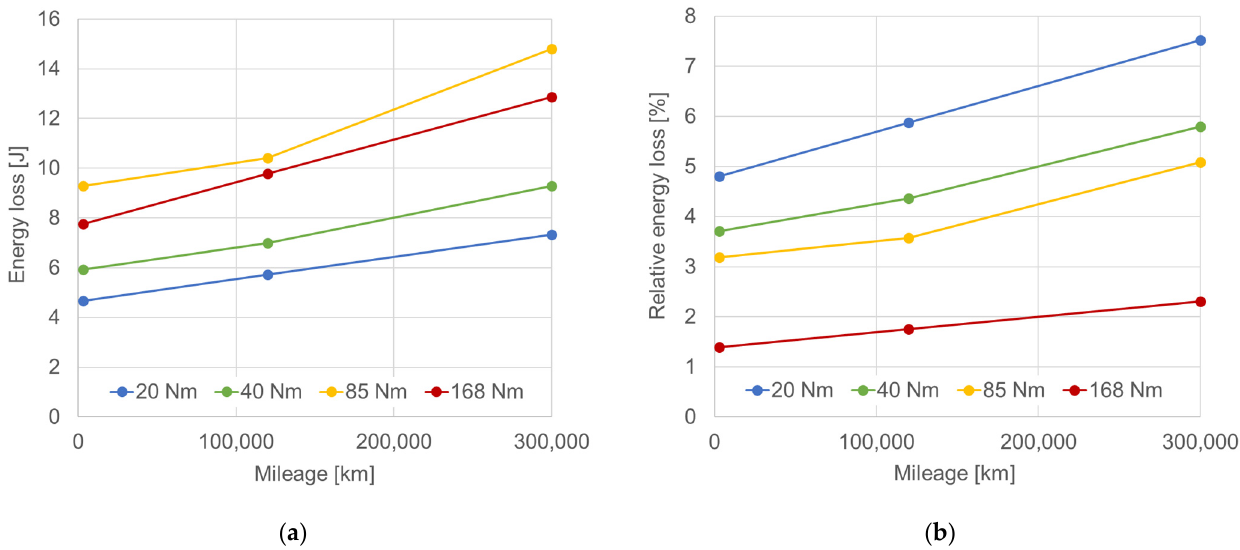
Figure 12. The energy lost by cycle due to blow-by at different engine loads and wear: ( a ) absolute values; ( b ) values related to indicated work.